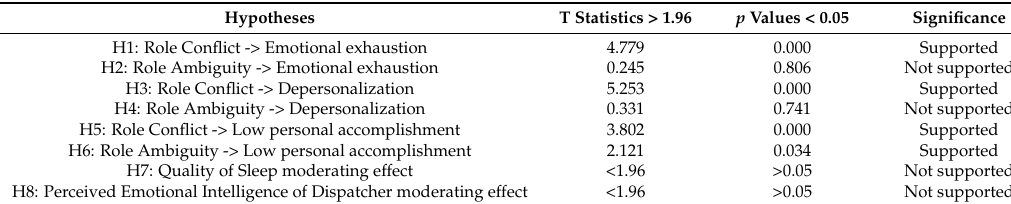
Figure 2. Empirically validated model. Table 5. Summary for hypotheses tested.